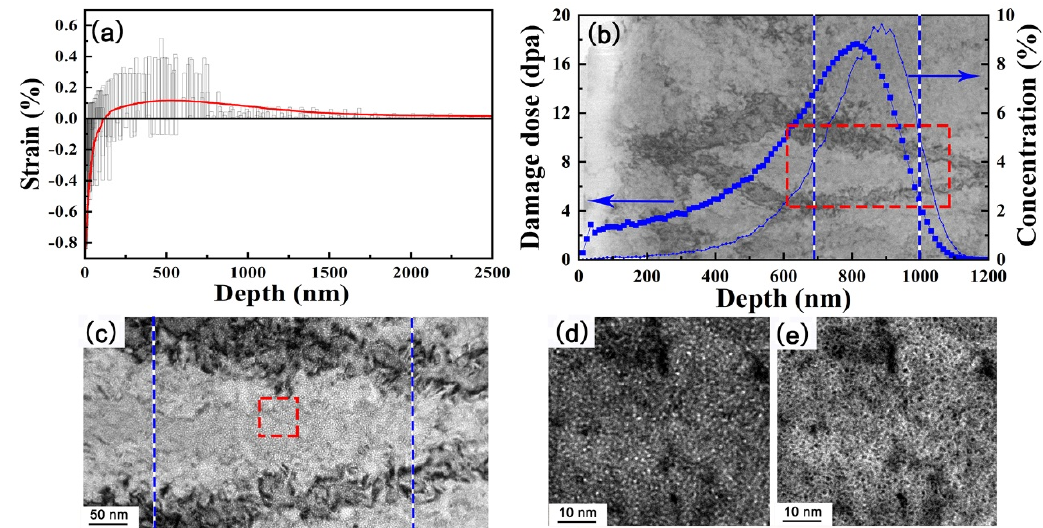
Figure 4. ( a ) Strain–depth profile at all 13 incident angles. ( b ) TEM image superposed with a SRIM simulation under 2 × 10 21 He ions/cm 2 irradiation. ( c ) Enlarged TEM images in the range of 600–1100 nm. ( d ) Under-focused and ( e ) over-focused enlarged TEM images in the range of 800–860 nm.